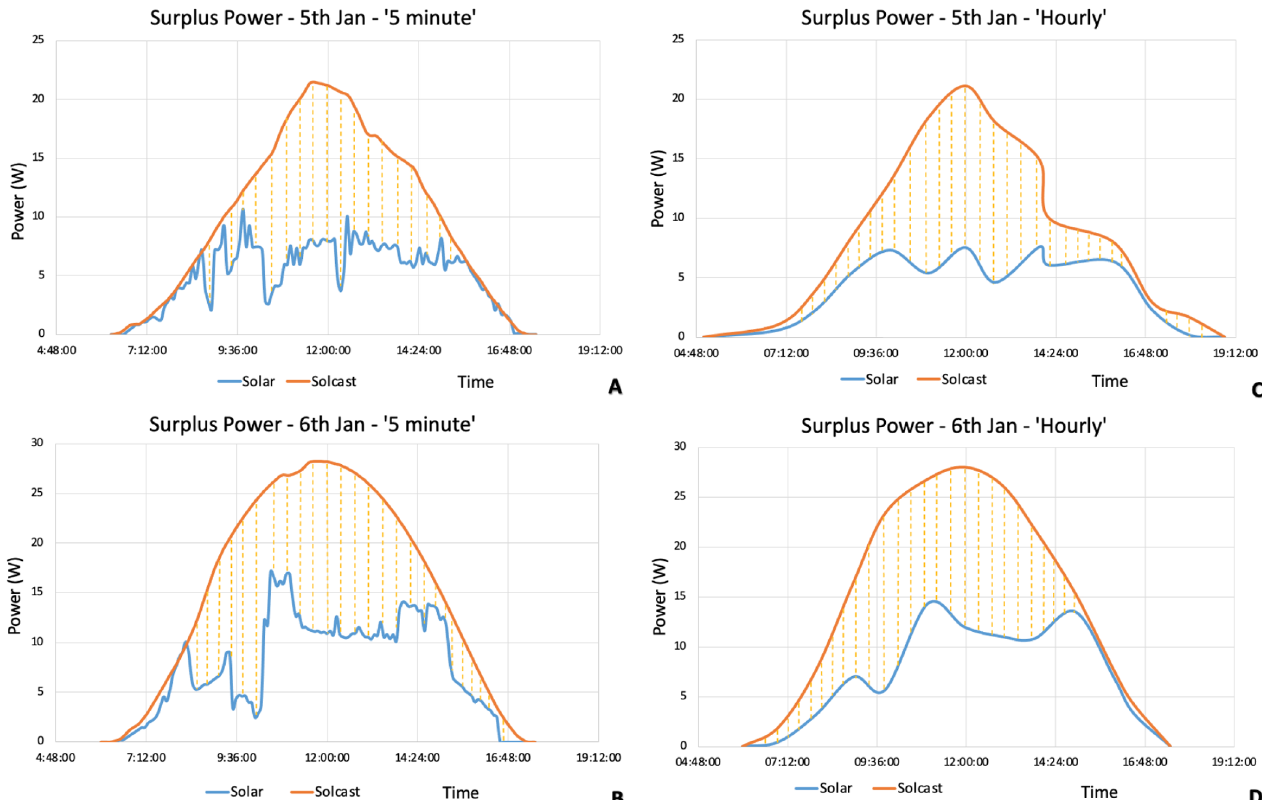
Fig. 3. Surplus Power on 5-minute; (A) 5th Jan; (B) 6th Jan & on an hourly scale (C) 5th Jan; (D) 6th